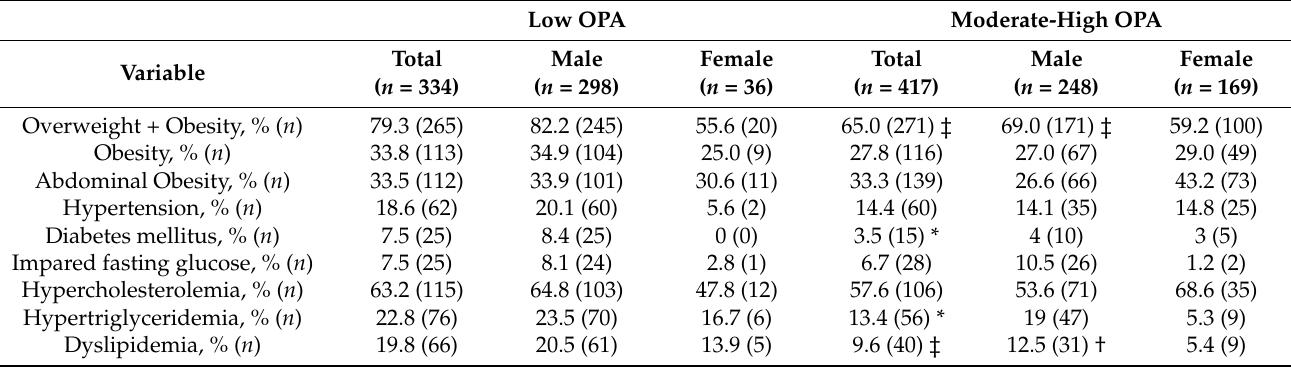
Table 2. Medical conditions of participants according to occupational physical activity (OPA). Low OPA